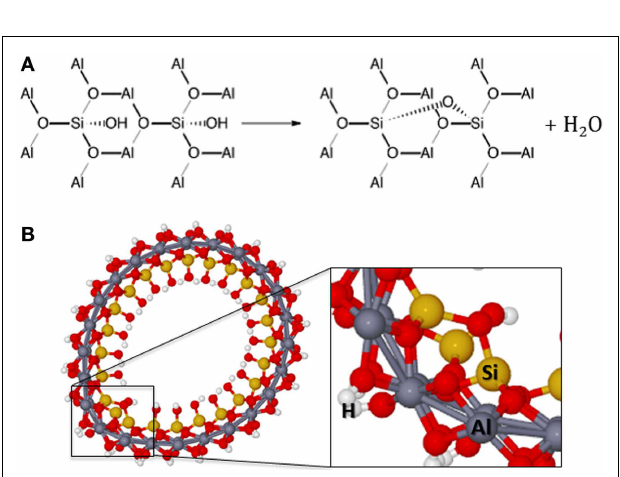
FIGURE 6 | (A) Dehydroxylation reaction scheme in the inner surface. (B) Structure of the first dehydroxylation of the imogolite.